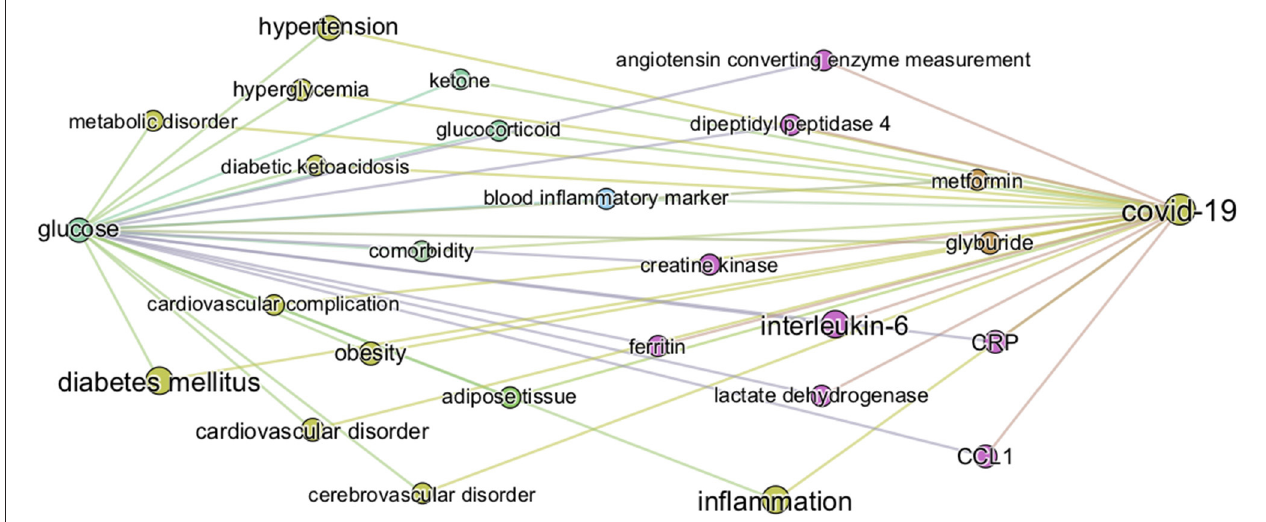
FIGURE 5 | Top 25 BMIPs from glucose to COVID-19. The knowledge graph is built from the 3,000 most relevant articles, and 1,500 most frequent entities, related to the query “glucose as a risk factor for COVID-19” as detailed in methods. The size of a node indicates the frequency of the corresponding entity in the COVID-19 literature (measured by the weighted degree centrality of the node), whereas the thickness of the edge indicates the strength of association between a given pair of entities (corresponding to the non-negative pointwise mutual information, see section Methods for more details). Their position and distance have no significance. The figure represents the most relevant intermediary terms associating glucose and COVID-19 in the